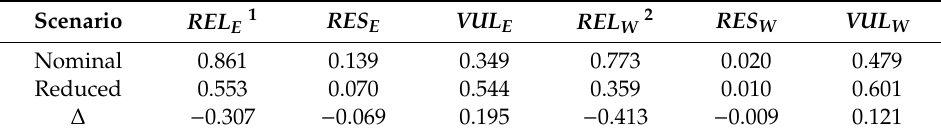
Table 11. Benchmark network performance